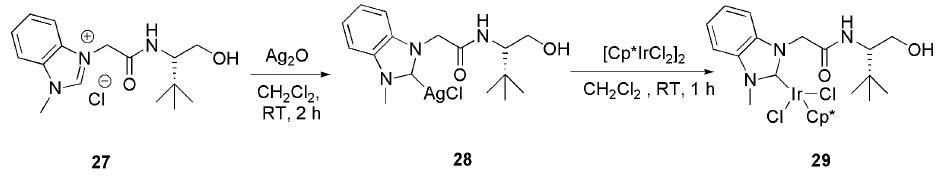
Scheme 9. Synthesis of precatalyst 29 [119]. Cp* = Me 5 -Cp.